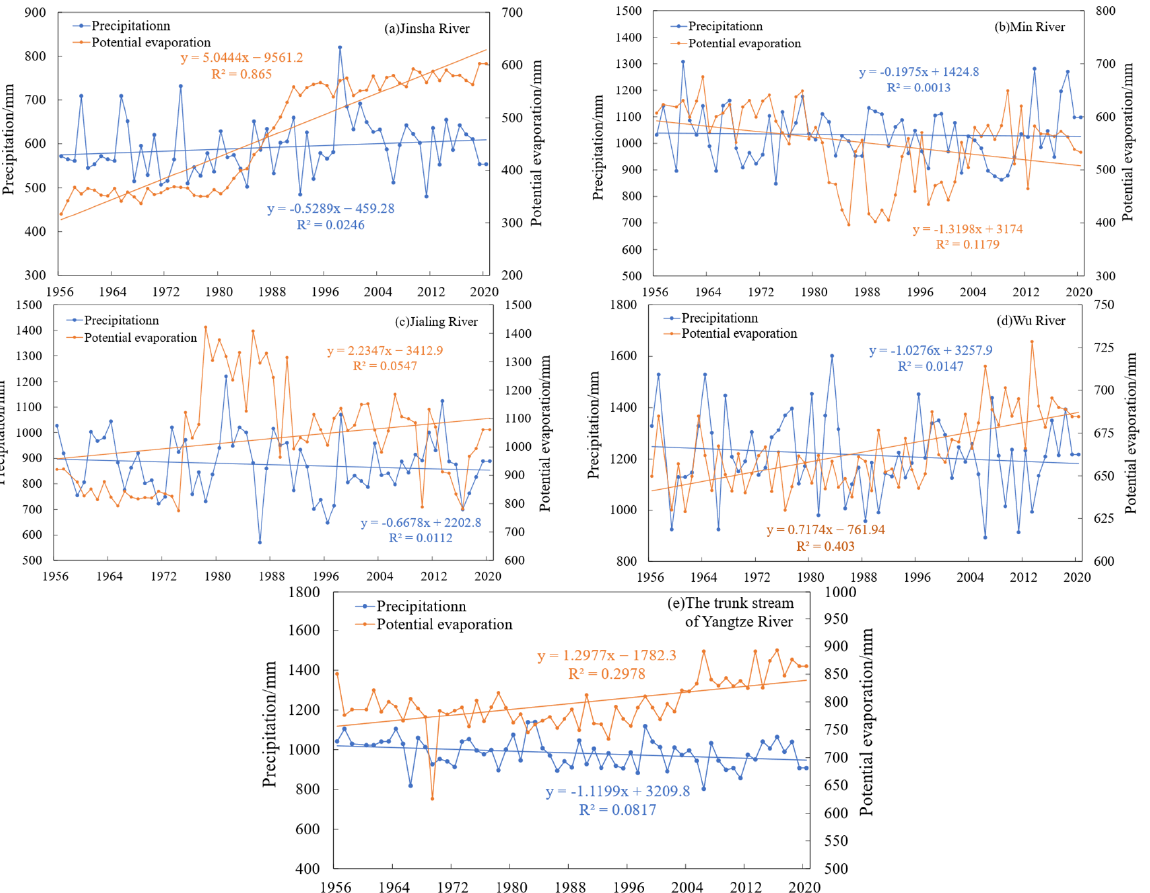
Figure 9. Evolution of multi-year average potential evapotranspiration and precipitation in the upper Yangtze River from 1956 to 2020.